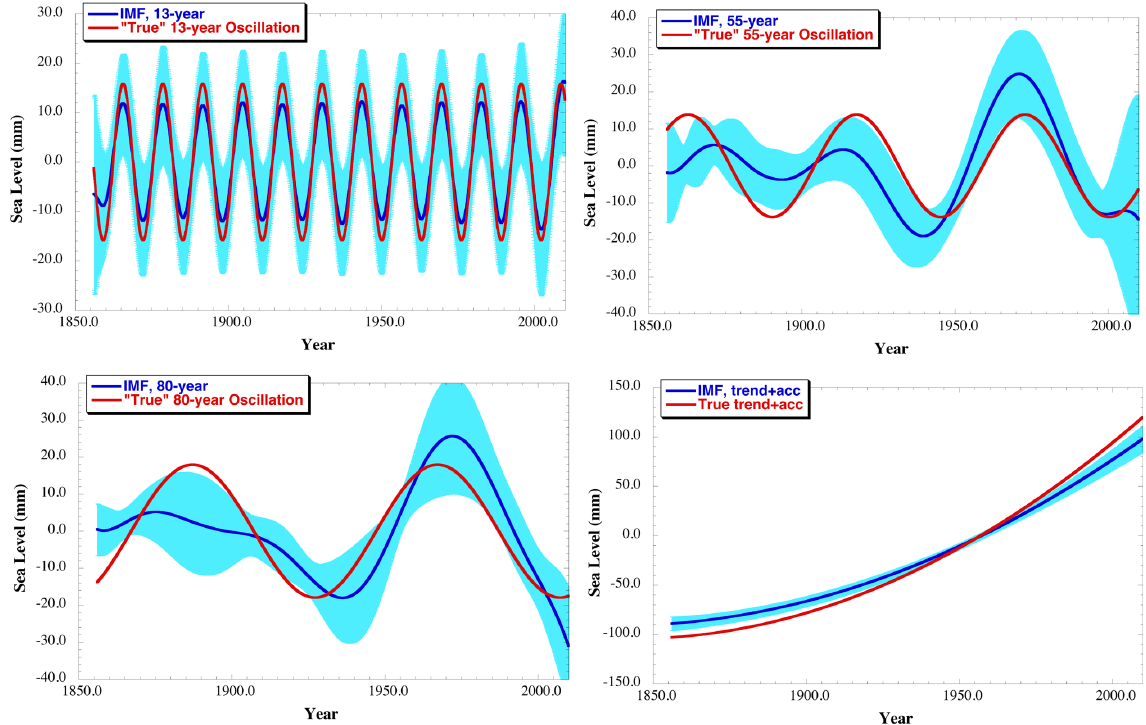
Figure 5. Mean (solid blue line) and standard deviation (light blue envelope) of IMFs calculated from the 1000 different case 1 simulations, along with the true signal